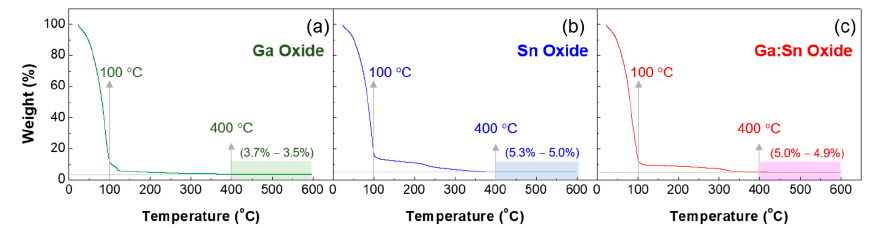
Figure 1. TGA (thermogravimetric analyzer) characteristic curves of the prepared sols: ( a ) the Ga oxide and ( b ) Sn oxide precursor solutions and ( c ) the mixture of Ga oxide and Sn oxide precursor solutions.